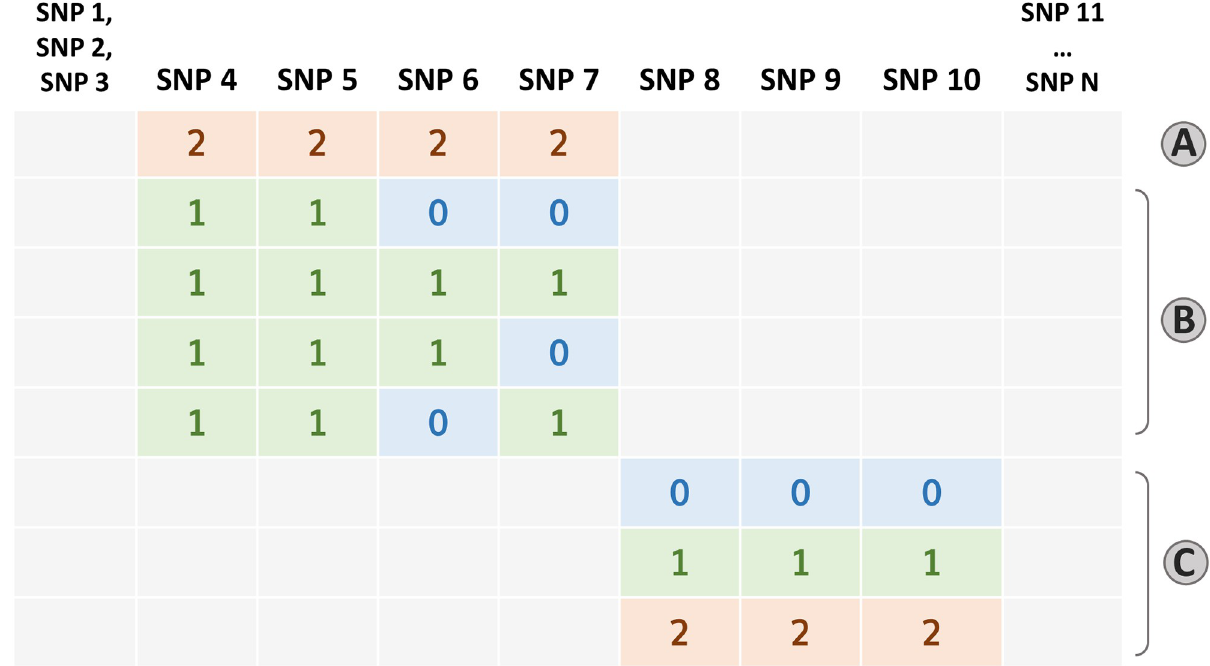
Fig 3. Simulation data generating rules. Graphical representation of the three rules that determine the positive class. Cases are obtained when A _ B _ C . More details on the generative model are provided in the Materials and Methods Section.